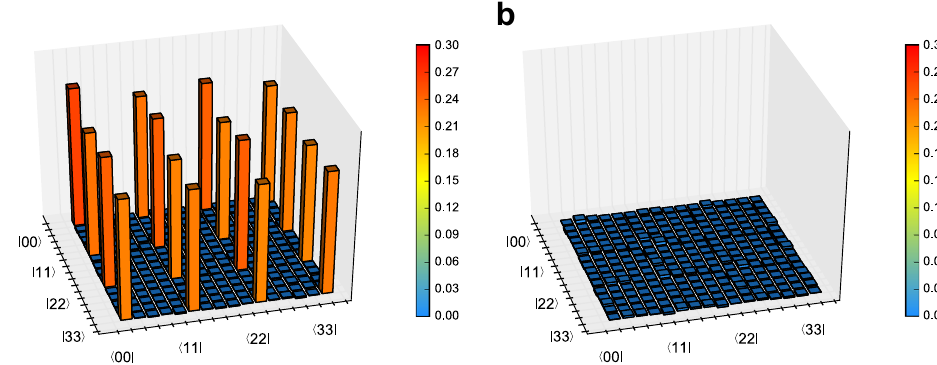
Figure 3. Experimental results. ( a ) Real and ( b ) imaginary parts of the density operator reconstructed by QST. The data shown here were averaged over four trials. To increase readability, the local phase rotation ^ φ φ = ∑ − | | ⟩ ⟨ U ik k k ( ) exp( ) k s